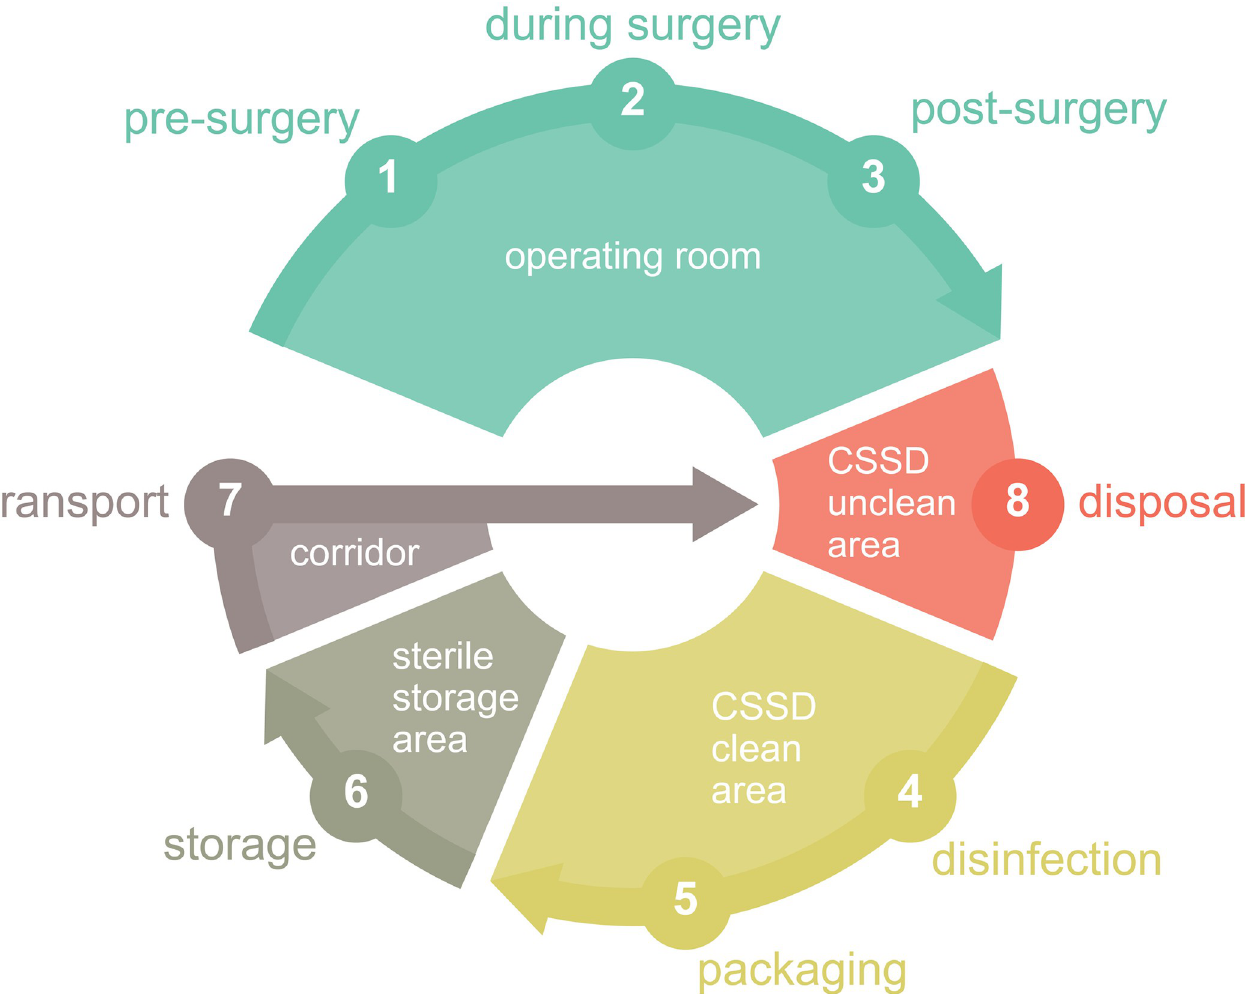
Fig 1. Steps and locations of sampling during use and reprocessing of sterile goods. The microbial load on instruments was sampled pre-surgery (1), post- surgery (3), after disinfection (4), after packaging (5), storage (6), and disposal (8). Samples on the outer surface of sterile packaging systems (reusable containers) were sampled pre-surgery (1), after disinfection (4), after packaging (5), storage (6), and disposal (8). Airborne microbial load (via impactor and settle plates) and airborne particle load (using particle counter) were measured at all steps and locations of sampling during use and reprocessing (1–8).